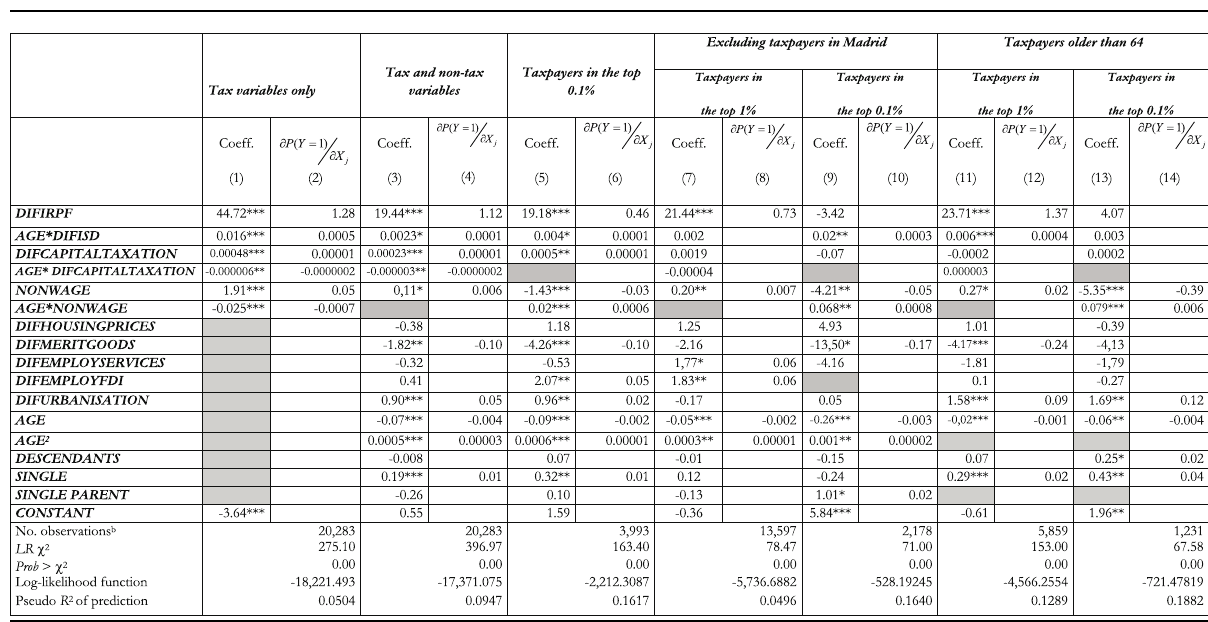
Table 7: Results of the probit/logit a estimates for the di ff erent scenarios proposed